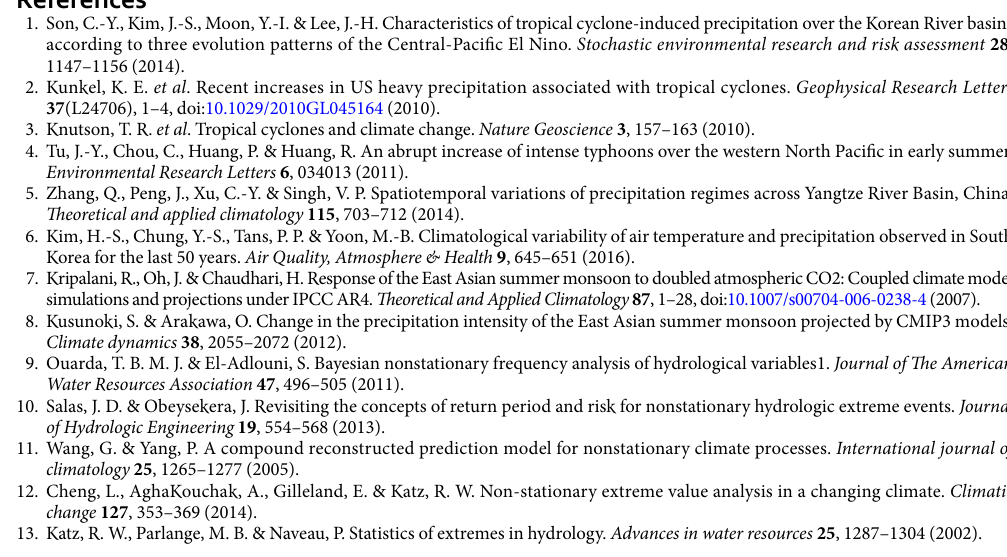
nonstationary model with the time-varying location parameter that was linearly dependent on